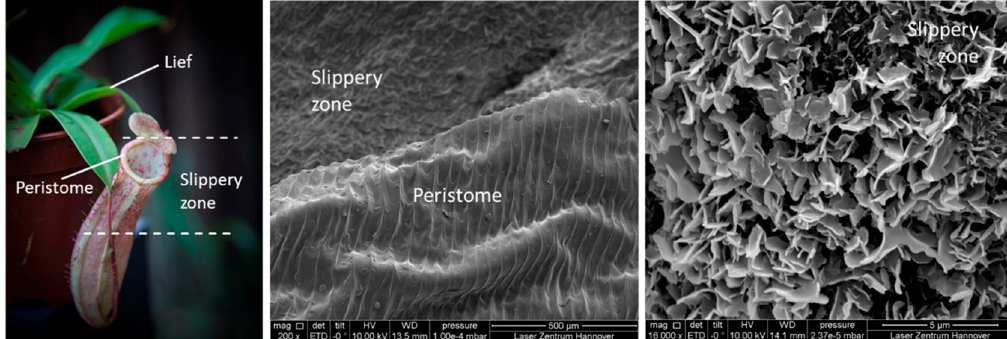
Figure 9. Nepenthes pitcher organization ( left ), SEM image of peristome and slippery surface ( middle ), detailed image of slippery zone ( right ).